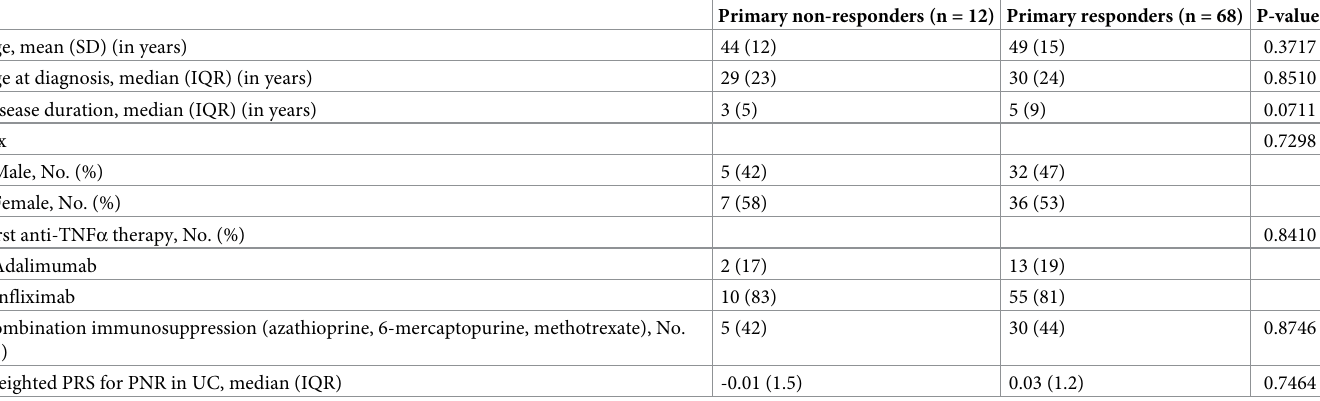
Table 3. Comparison of characteristics of patients with ulcerative colitis exposed to anti-tumour necrosis factor alpha therapy with primary non-response and pri- mary response.